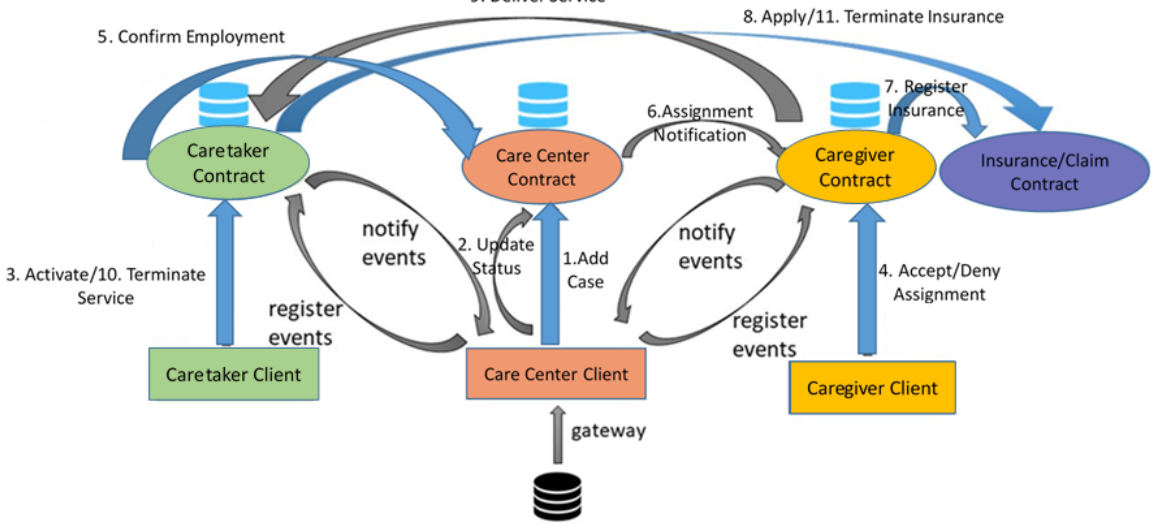
Figure 4. Framework of the proposed blockchain-based home care